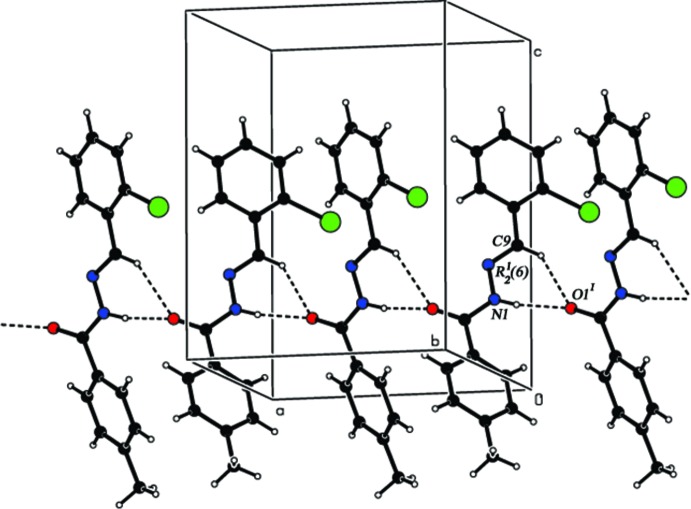
Part of the crystal structure with hydrogen bonds shown as dashed lines.